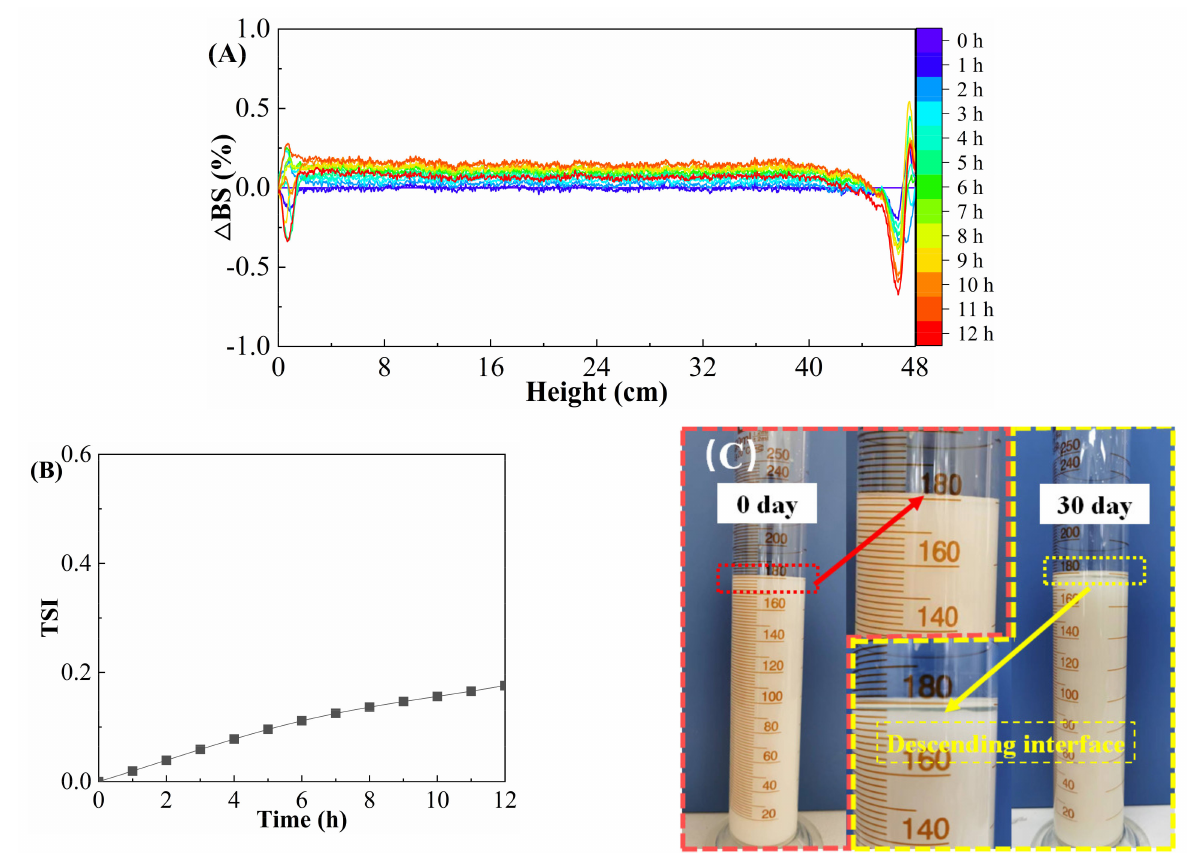
Figure 2. The stability evaluation of suspension SACM. ( A ) Back scattering spectra. ( B ) TSI values. ( C ) The status after standing for 30